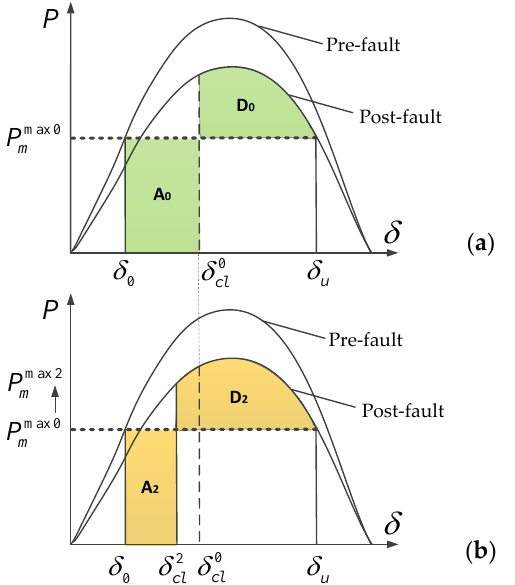
Figure 6. ( a ) Diagram of power-angle curves when T J = T J 0 . ( b ) Diagram of power-angle curves when T J = T J 2 .